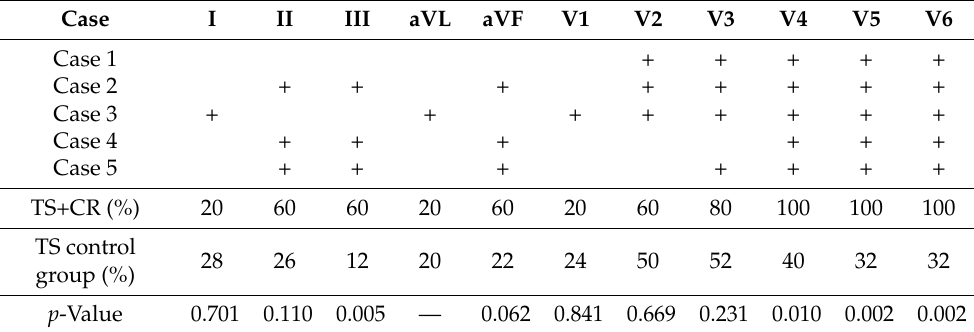
Table 2. ST segment elevations in patients with Takotsubo syndrome and cardiac rupture.